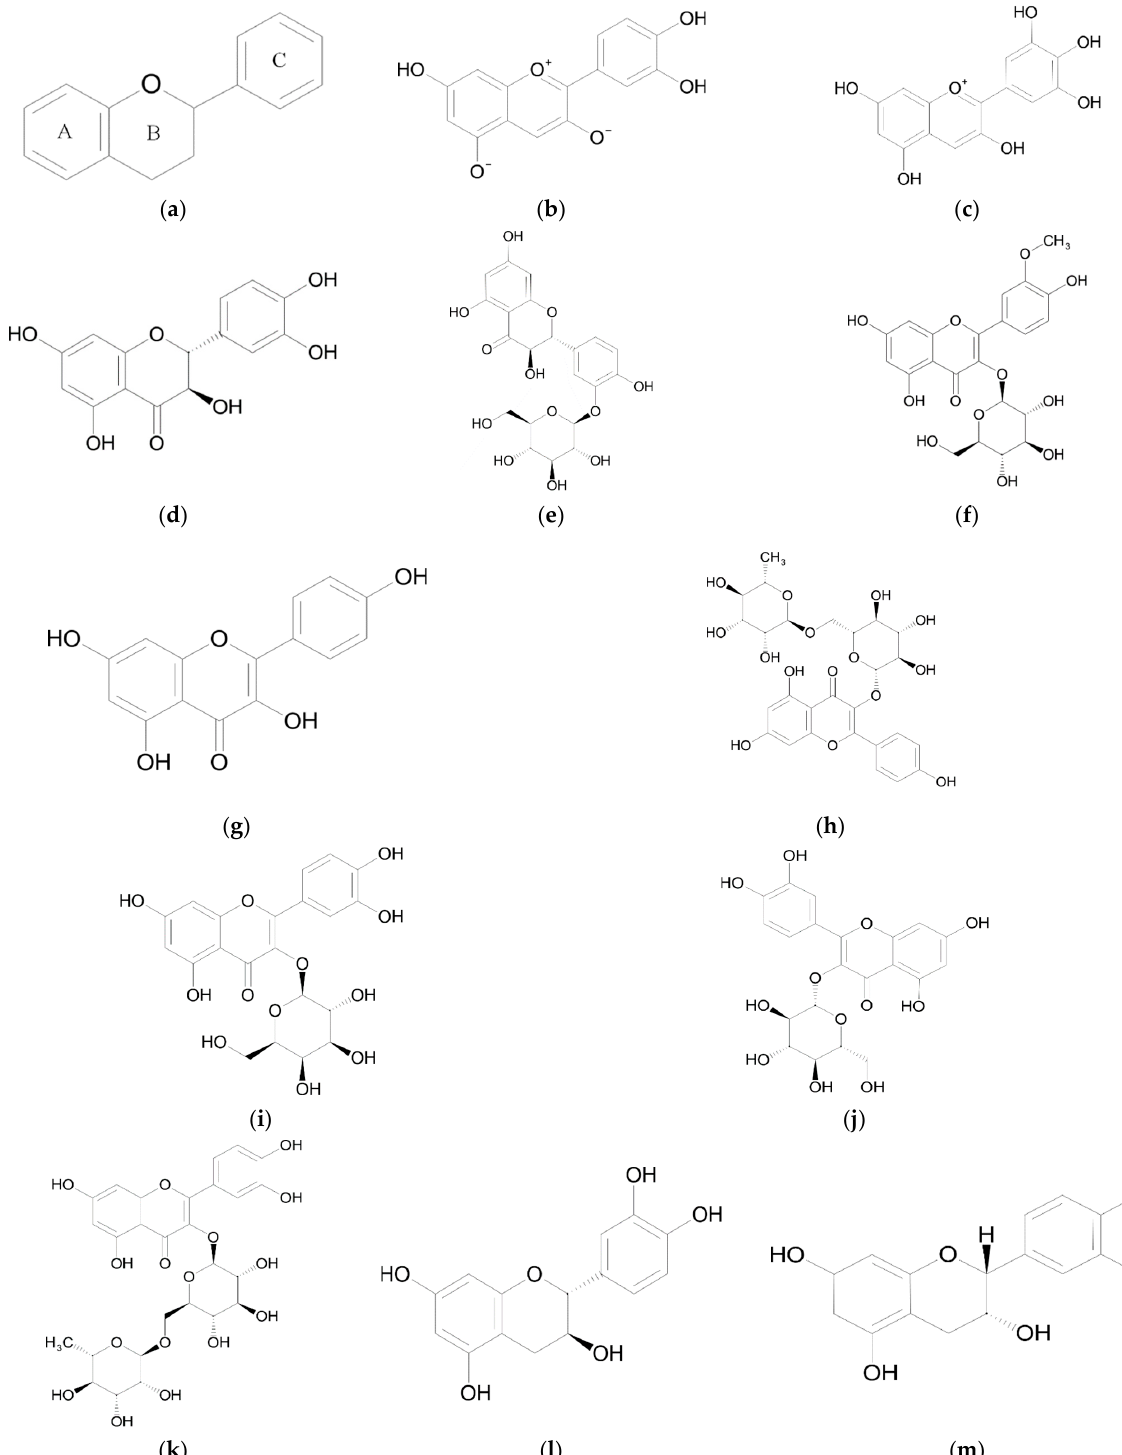
Figure 1. Chemical structures of flavonoids and flavonoid glycosides from Sarraceniaceae species: ( a ) basic flavonoid structure; ( b ) cyanidin; ( c ) delphinidin; ( d ) taxifolin; ( e ) taxifolin-3-O-glucoside; ( f ) isorhamnetin-3-O-glucoside; ( g ) kaempferol; ( h ) kaempferol-3-O-rutinoside; ( i ) quercetin-3-O-galactoside; ( j ) quercetin-3-O-glucoside; ( k ) quercetin-3-O-rutinoside; ( l ) (+)-catechin; ( m ) ( − )-epi-catechin.